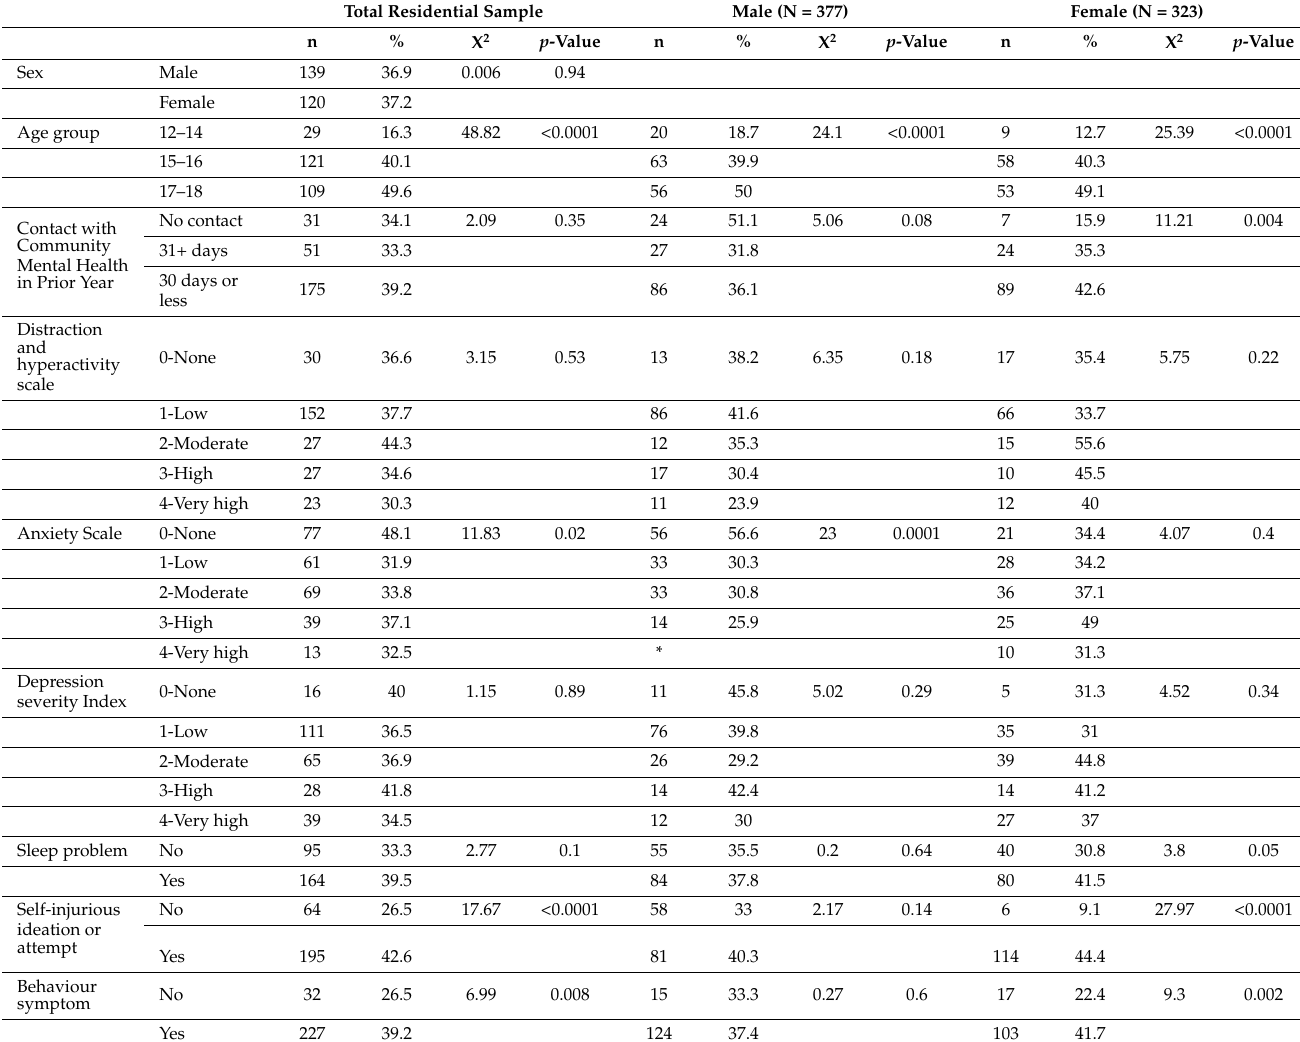
Table 4. Pattern of substance use among youth with mental health conditions assessed in residential settings stratified by